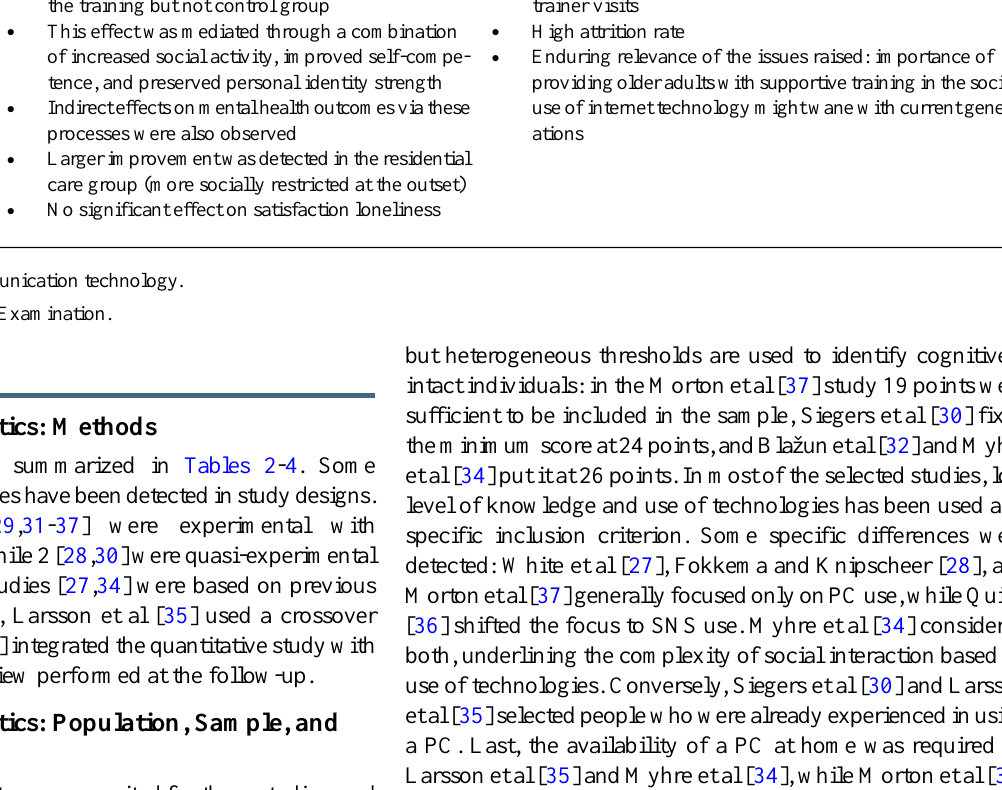
Protocol Characteristics: Control Groups,